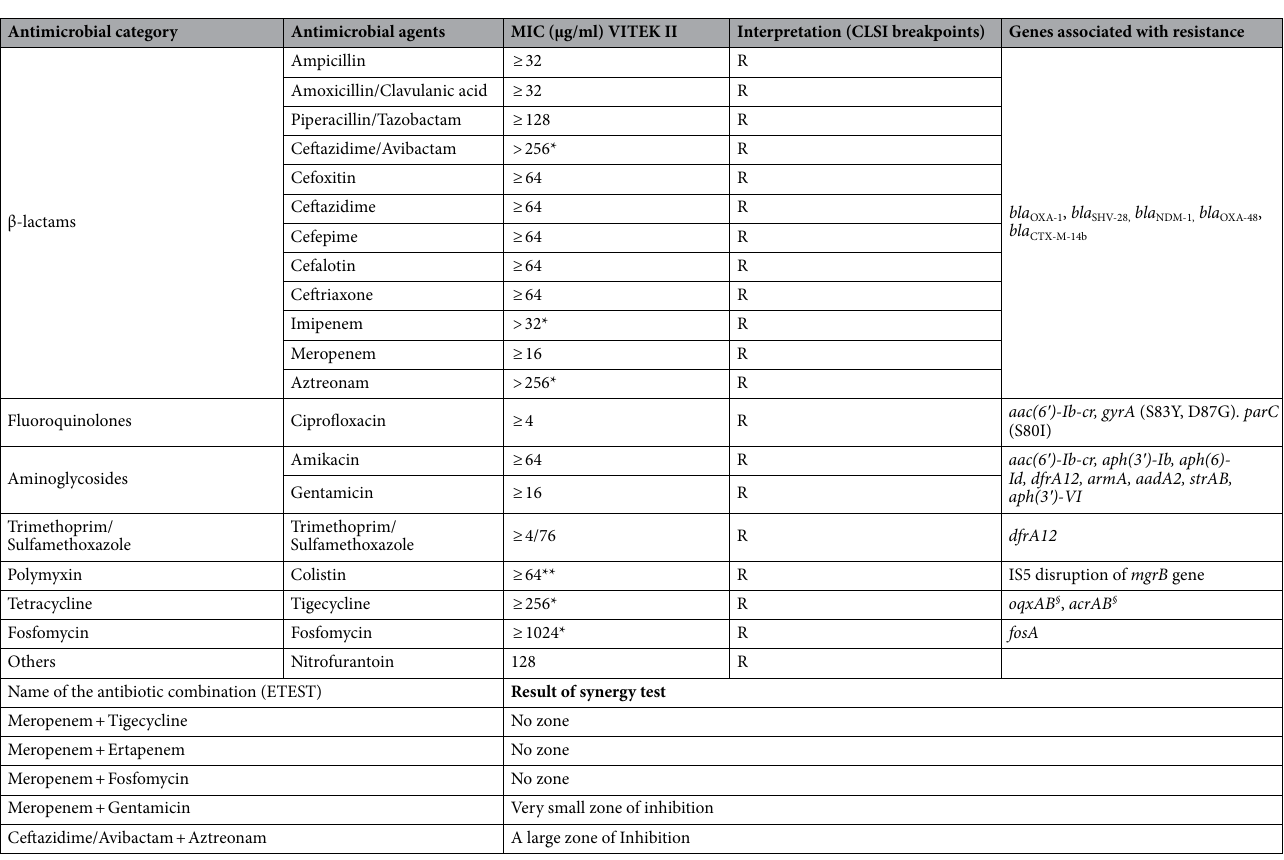
Table 1. Antibiotic resistance in K. pneumoniae SA-KpST14. * ETEST method. **Broth Micro Dilution method. § No genetic evidence was found to infer overexpression.